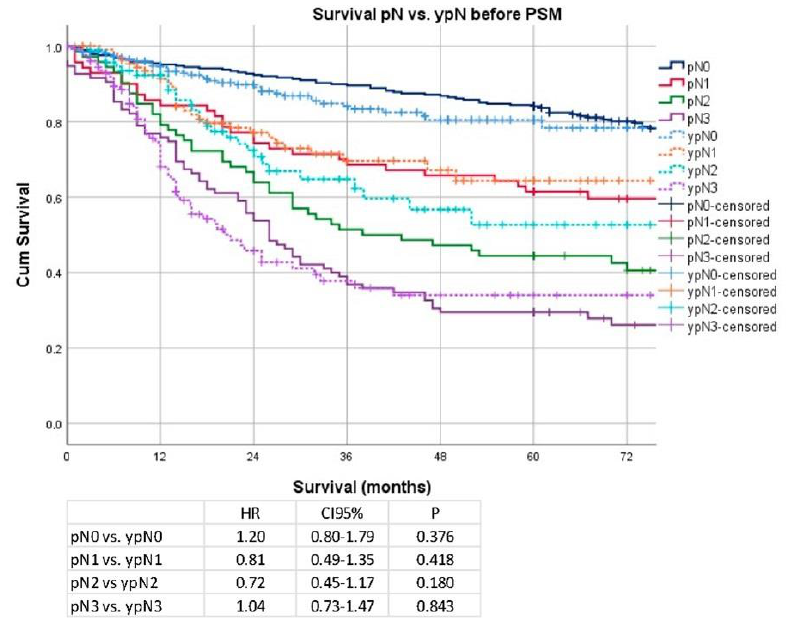
Figure 3. Kaplan–Meier analyses according to pN/ypN stages before PSM. All factors were included in the multivariable model without selection. Univariable regression analysis revealed age, localization, clinical stage, none and severe complications, UICC stage 0, IIB-IIIC, Lauren subtype, grading, and R-stage to be significantly associated to post-therapeutic survival (Table 2. Multivariable analysis demonstrated that age, distal tumor localization, D2-lymphadenectomy, UICC stage 0, IIB-IIIC, and Lauren subtype were significantly and independently related to postoperative survival (shown in Table 3). Table 2. Univariable analysis (all patients).